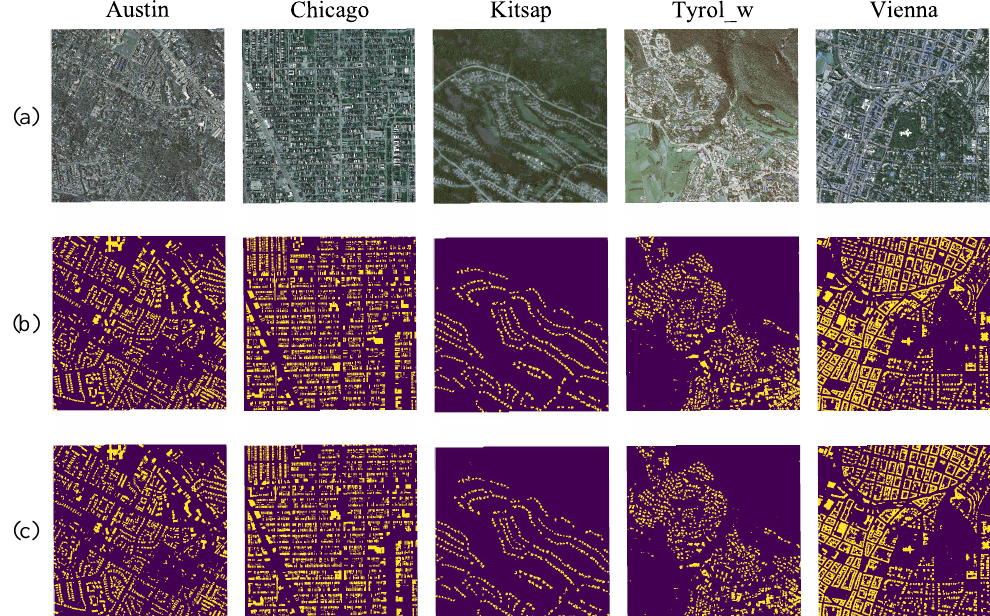
Figure 5. Building extraction results of our GMEDN model. Five images are randomly selected from the Inria dataset. They belong to Austin, Chicago, Kitsap, Tyrol_w, and Vienna cities